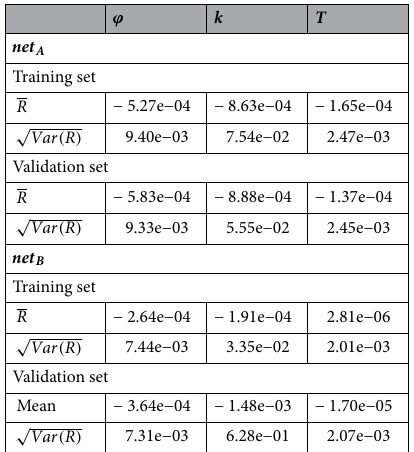
Table 2. The mean of R and √ Var ( R ) computed from the predictions of networks net A and net B . R is defined by Eq. (11).